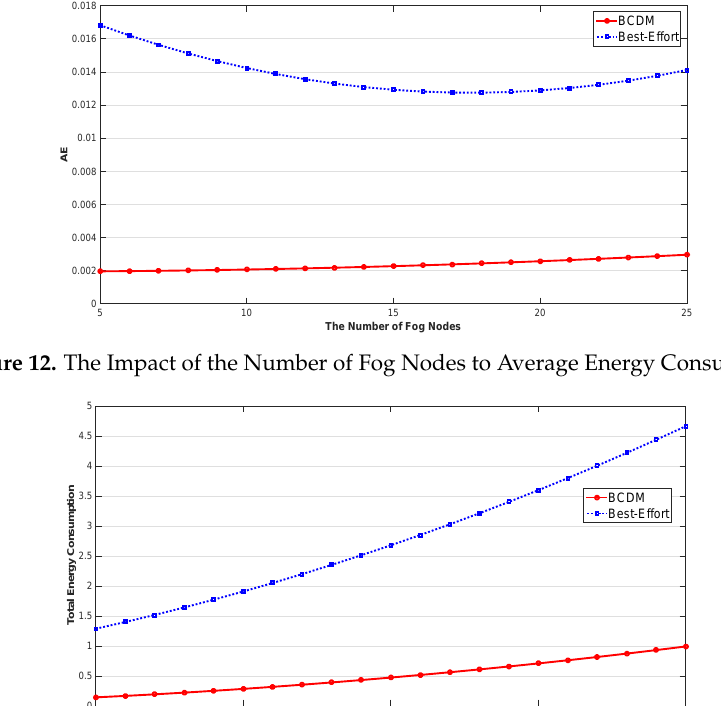
Figure 11. The Impact of the Number of MEC Nodes to Total Number of Allocated Tasks.